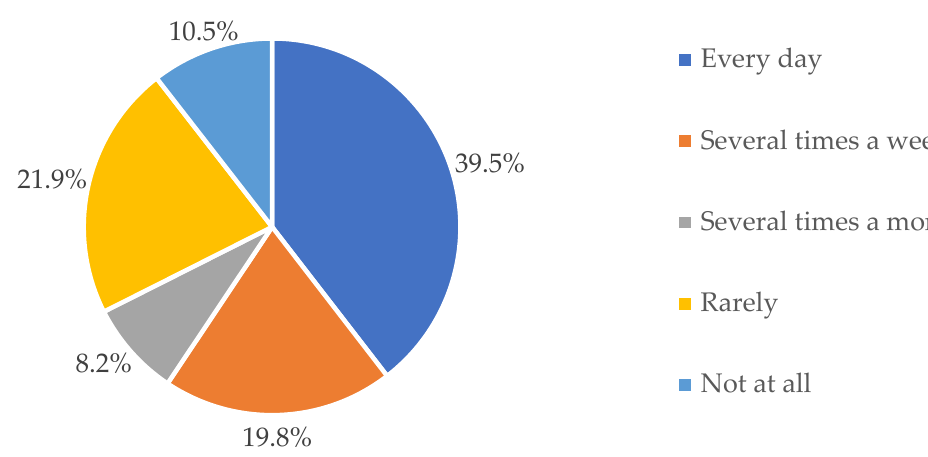
Figure 5. Distribution of students by frequency of use of public transport (%). Table 6. The statistical relationship values for relation between the class number and frequency of public transport